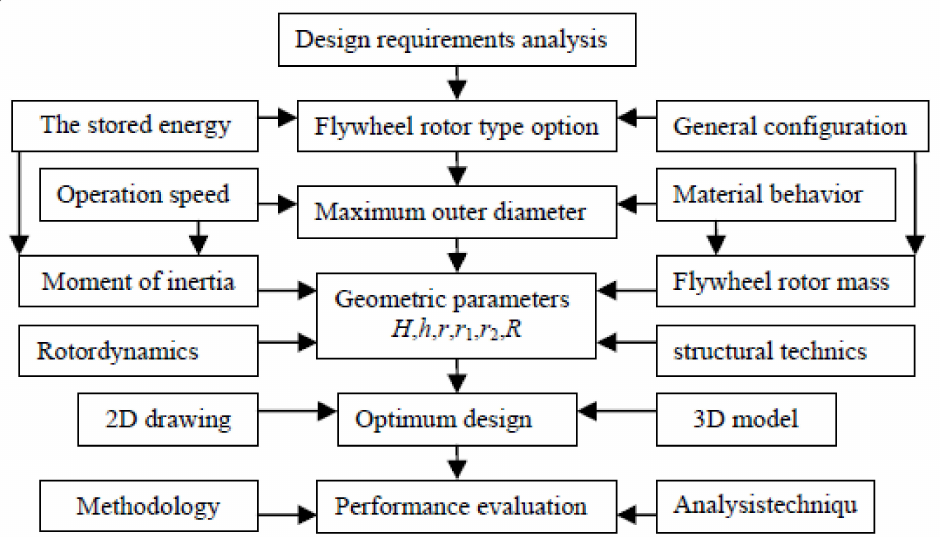
Figure 24. Flywheel rotor design process and its influence factor, reproduced with permission from